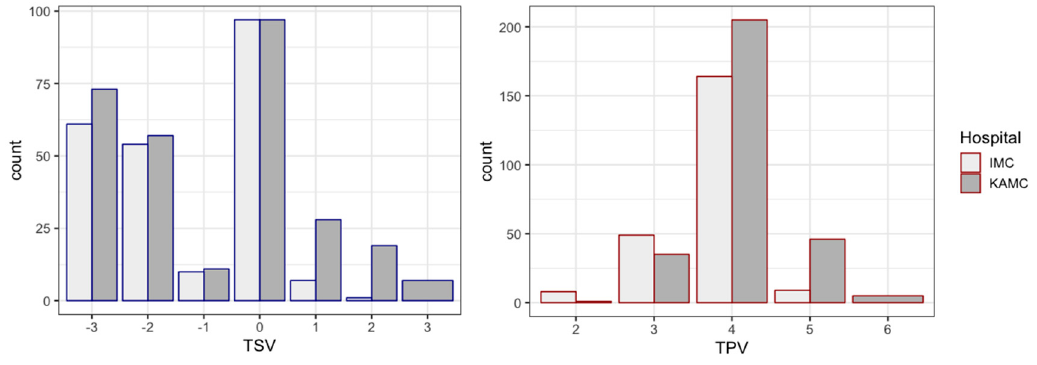
Figure 5. Distribution of thermal sensation votes (TSVs) and thermal preference votes (TPVs) in both hospitals.